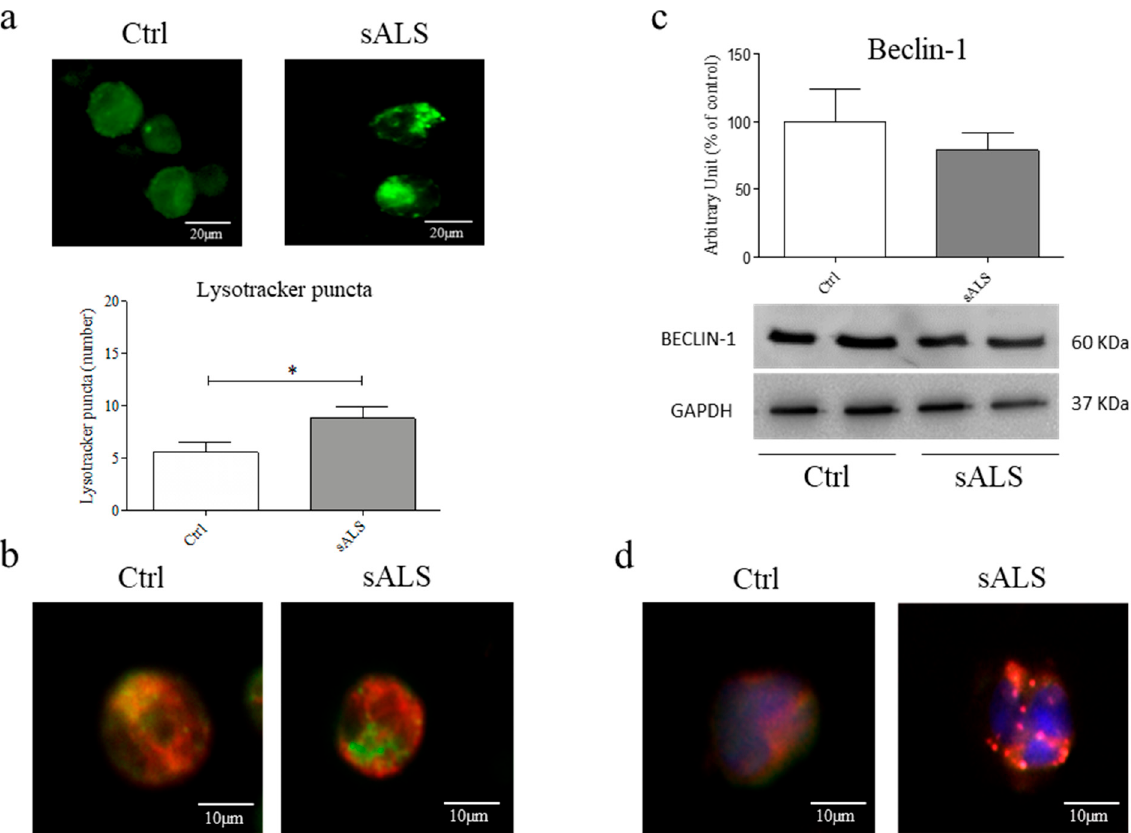
Figure 3. Inhibition of fusion between autophagosomes and lysosomes. ( a ) Immunofluorescence analysis with LysoTracker™ marker revealed an accumulation of lysosomes in sALS patients’ PBMCs. We found a statistical increase in the number of puncta in sALS compared to control (* p < 0.05). Scale bar: 20 µ m. N = 3 ( b ) Immunofluorescence analysis with LC3 and LysoTracker™ revealed that the fusion between lysosomes and autophagosomes is inhibited. Green: LysoTracker™; Red: LC3. Scale bar: 10 μ m. N = 3 ( c ) WB analysis revealed no statistically significant differences between levels of Beclin-1 in sALS patients and control. GAPDH was used as a loading control. N = 32 ( d ) Immunofluorescence analysis with ER-Tracker™ revealed that mitochondria (Red) and ER (green) do not co-localize. Scale bar: 10 µ m. N =